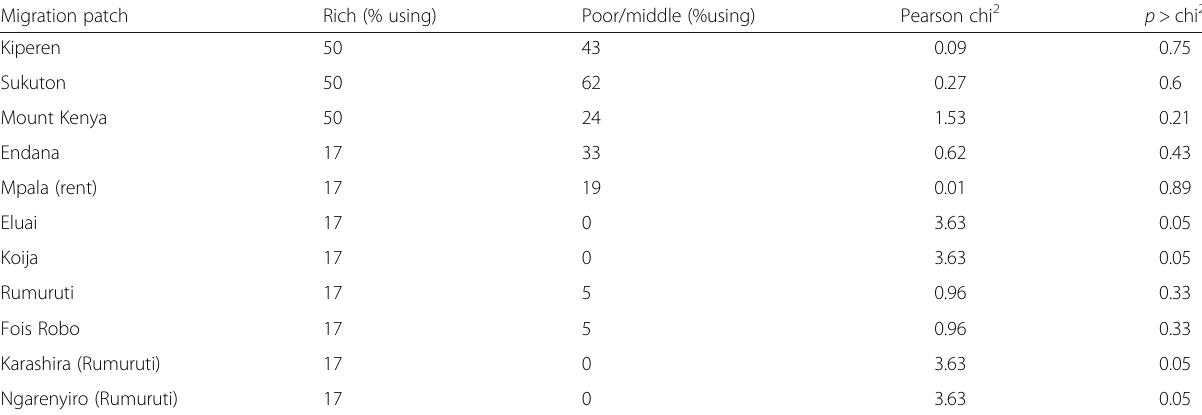
Table 3 Results of Pearson product-moment correlation analysis between rich and poor/middle class herders on migration patch use during the 2009 drought year Migration patch